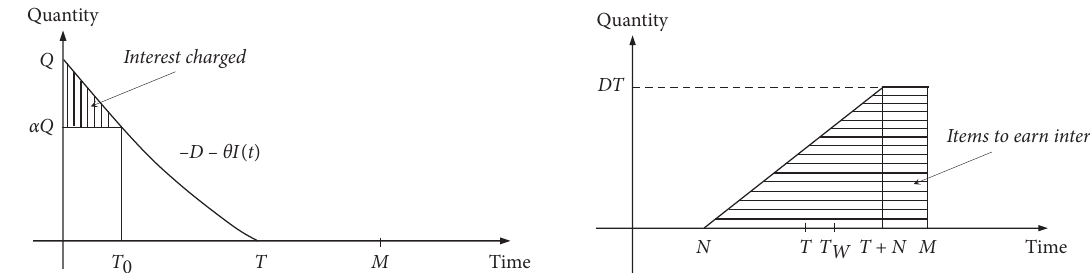
Figure 4: The interest charged (left) and earned (right) of the retailer when T < T